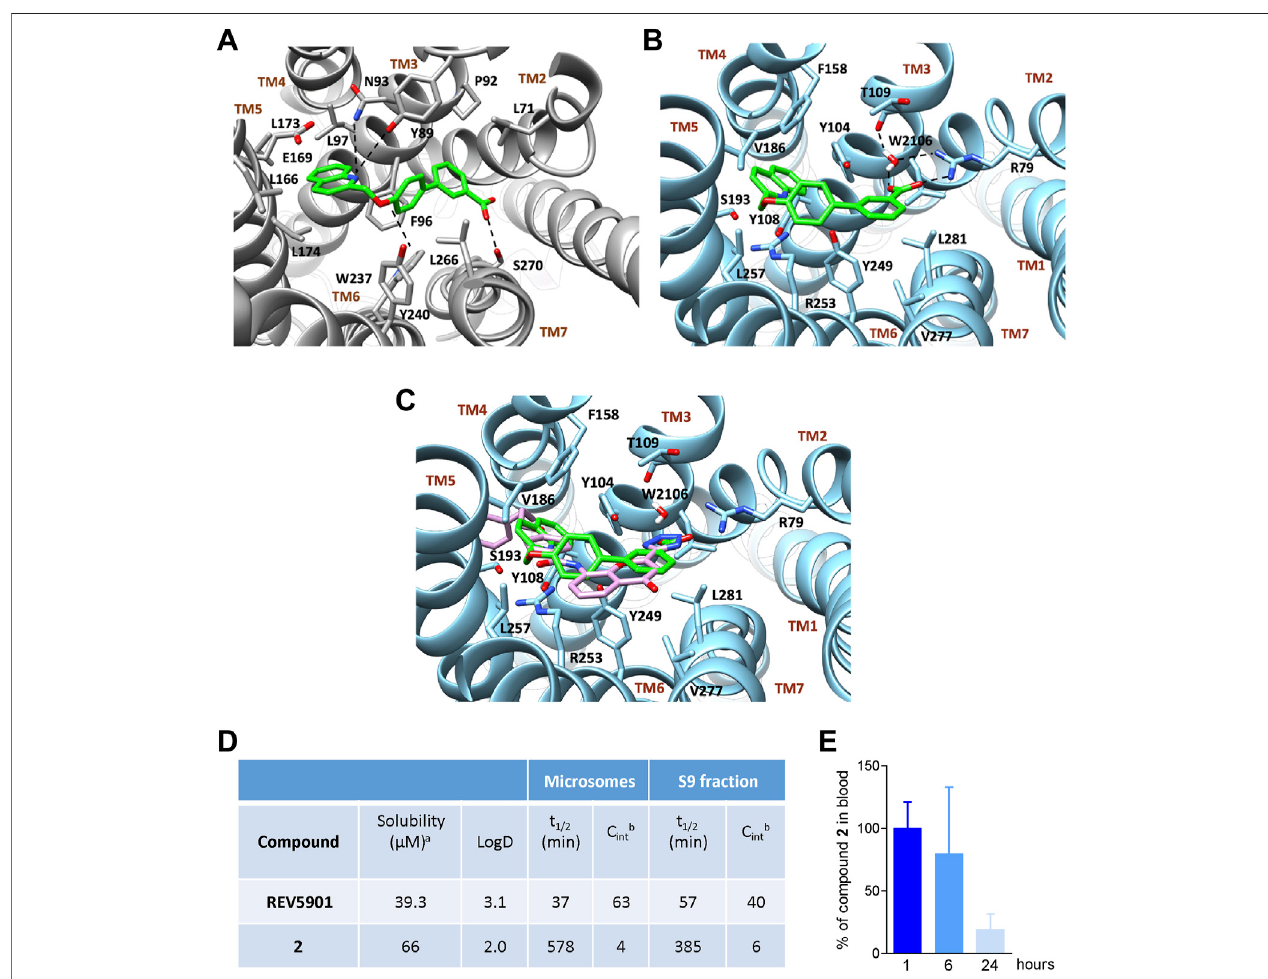
FIGURE 3 | Binding mode in GPBAR1 and CysLT1R and in vitro and in vivo evaluation of the pharmacokinetics for compound 2. Binding mode of compound 2 (green stick) in GPBAR1 (A) (gray cartoon) and CysLT 1 R (B) (sky-blue cartoon). Superimposition between compound 2 (green stick) and the co-crystalized ligand pranlukast (plum stick) (C) in CysLT 1 R (sky-blue cartoon). The interacting residues of the receptor are shown in stick and labeled. TMs of the receptors are labeled. Oxygen atoms are depicted in red and nitrogens in blue. Hydrogens are omitted for the sake of clarity and H-bonds are displayed as black dashed lines. The bridging water molecule is reported as red sticks with explicit hydrogens. (D) In vitro pharmacokinetics for selected derivative. a Aqueous solubility at pH 7.4; b Reported as μ l/min/mg protein. Results are mean of at least two experiments. (E) Measurement of the amount of compound 2 in the blood of mice at 1, 6, or 24 h after administration at the dose of 30 mg/kg. Results are the mean ± SD of 5 mice per